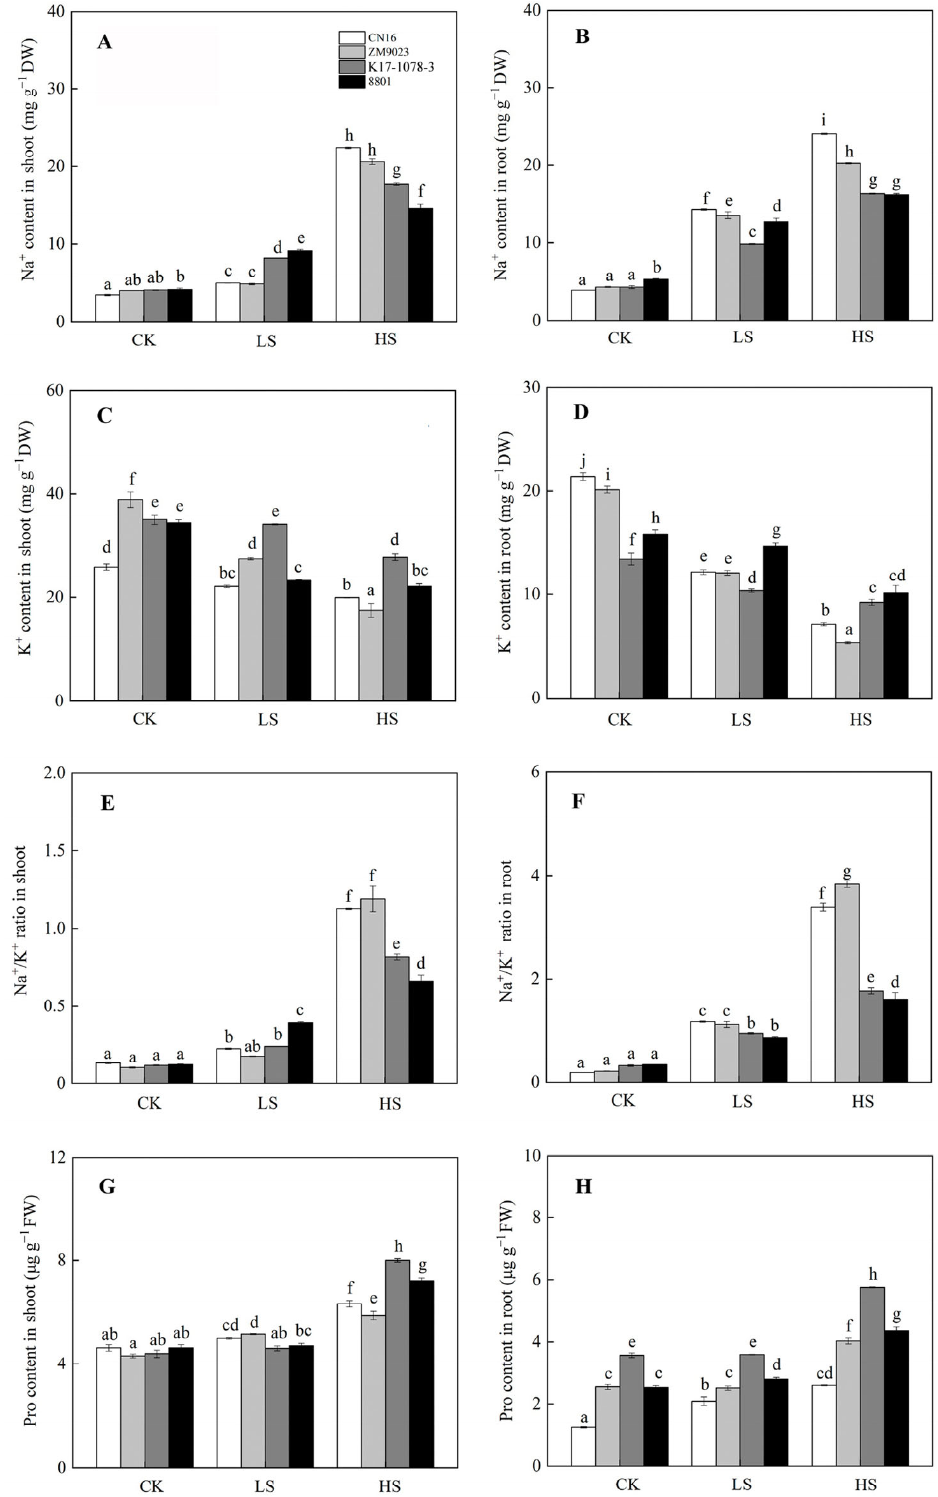
Figure 4. The Na + accumulation in shoot ( A ) and root ( B ); K + accumulation in shoot ( C ) and root ( D ); Na + /K + ratio of shoot ( E ) and root ( F ); Pro content in shoot ( G ) and root ( H ) variations of K17-1078-3 and its parents subjected to different salinity levels. Different letters indicated significant difference due to salt treatments according to Duncan’s multiple range tests. CK, LS, and HS referred to NaCl concentrations of 0, 50, and 200 mM.